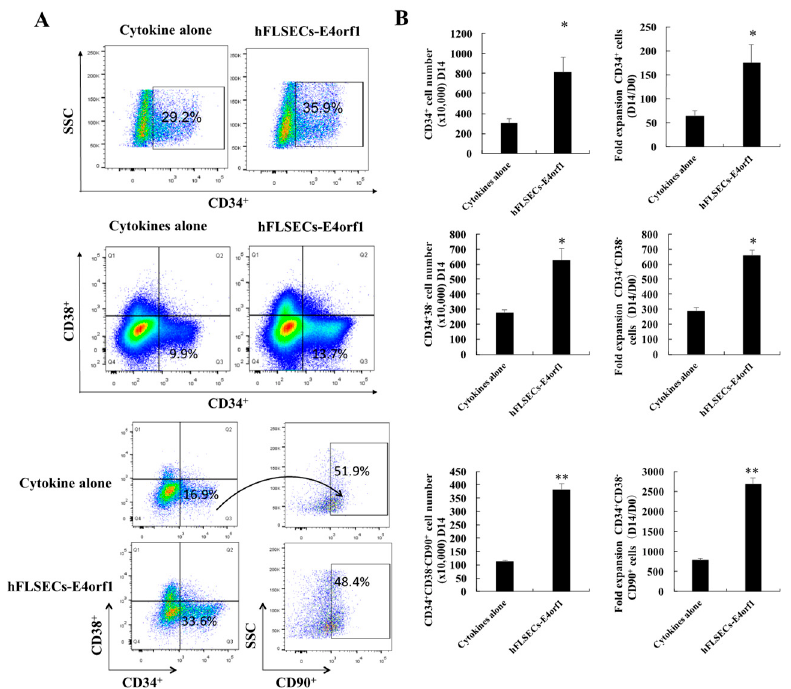
Figure 3. Coculture of hFLSECs-E4orf1 efficiently expanded human CB-HSPCs in vitro. ( A ) Phenotypic analysis of CD34, CD38, and CD90 expression on CD34 + hCB cells on day 0 and following cytokines culture alone and the hFLSECs-E4orf1 coculture for 14 days. Representative flow cytometry is shown. ( B ) Total expansion number and fold change of CD34 + cells, CD34 + CD38 − cells, and CD34 + CD38 − CD90 + cells. Data represented as mean ± SEM. n = 6. * p < 0.05, ** p < 0.01. (We have established three hFLSEC-E4orf1 cell lines, which have stable and consistent effects on ex vivo expansion of HSPCs.)